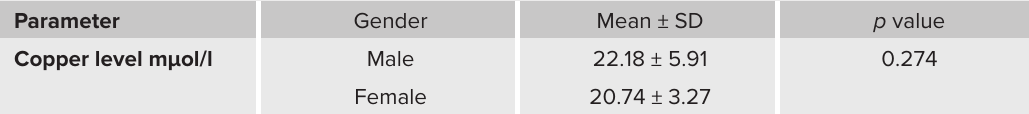
Table 3: Mean Comparison of Study Parameter across Gender.